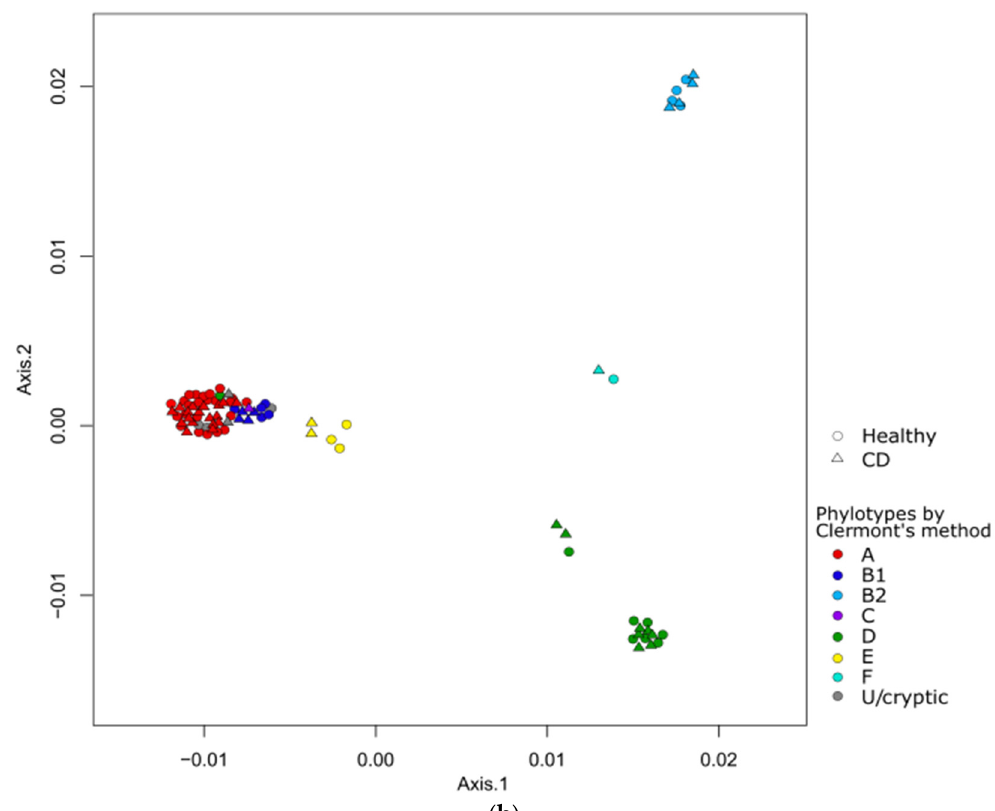
Figure 1. Comparative genome analysis of fecal E. coli strains isolated from patients with Crohn’s disease (CD) and healthy individuals. ( a ) Phylogenetic tree of 63 E. coli genomes and 18 MAGs (marked in bold) from healthy individuals (blue) and CD patients (red). Complete genomes of E. coli strains APEC O1, LF82, Sakai, EDL933, Nissle 1917, and K-12 substr. MG1655 were used as reference sequences (black). Phylogenetic groups by Clermont’s method [20] are highlighted on the inner ring. Sequence types (ST) by the Achtman’s scheme [49] and the Pasteur’s scheme [50] are marked as ST#1 and ST#2, respectively. Repeating STs are colored; ( b ) Multidimensional scaling (MDS) on average nucleotide identity (ANI) distance of all genomes is colored according to Clermont’s phylogroups.